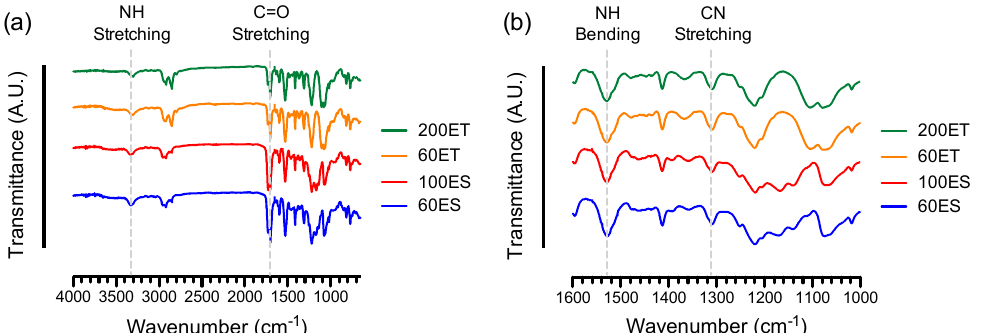
Figure 2. FTIR spectra of the various PU films for: ( a ) Wavenumbers from 650 to 4000 cm − 1 , showing the characteristic peaks of N–H stretching vibration at around 3300 cm − 1 and C = O stretching vibration from amide I band at around 1700 cm − 1 ; ( b ) wavenumbers from 1000 to 1600 cm − 1 , showing the characteristic peaks of N–H bending vibration from amide II band at around 1531 cm − 1 and C–N stretching vibration from amide III band at around 1314 cm − 1 that form the urethane linkage (– NHCO–).